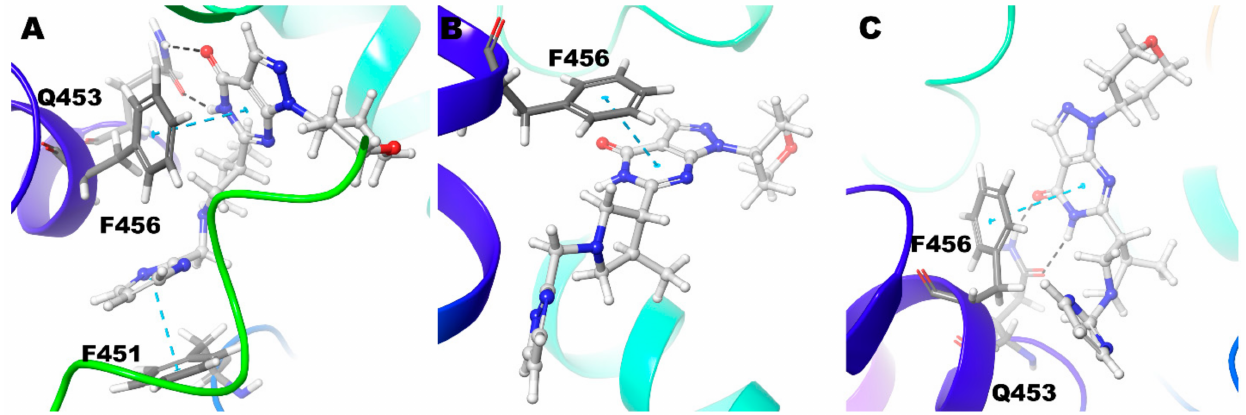
Figure 9. Non-bonded interactions of Compound 4 in ( A ) PDE9 Zn/Mg ( B ) PDE9 Mg/Mg ( C ) PDE9